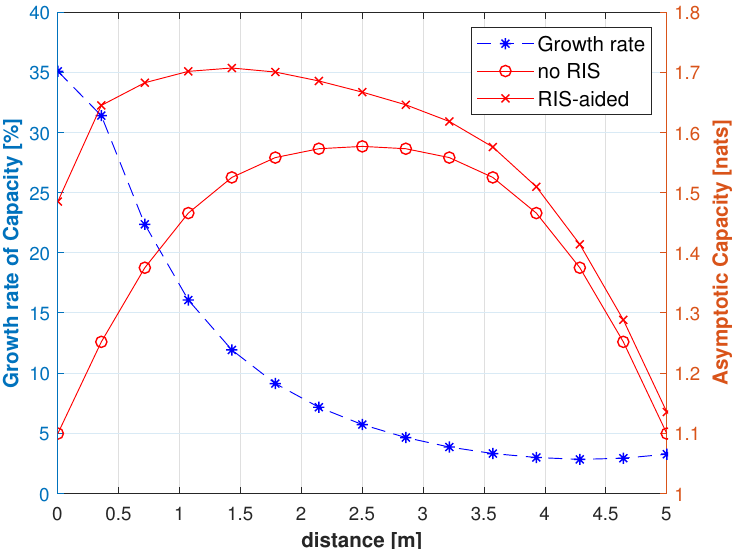
Figure 5. Asymptotic capacity and growth versus horizontal distance between receiver and RIS.